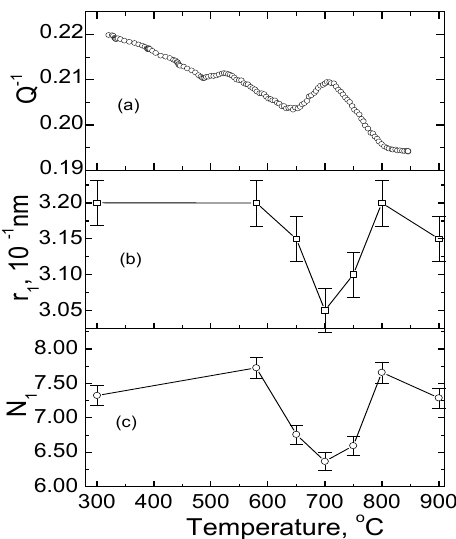
Figure 6. r 1 , N 1 of In-Sn80 compared with Q −1 - T versus temperature. ( a ) Q −1 versus temperature; ( b ) r 1 versus temperature; ( c ) N 1 versus